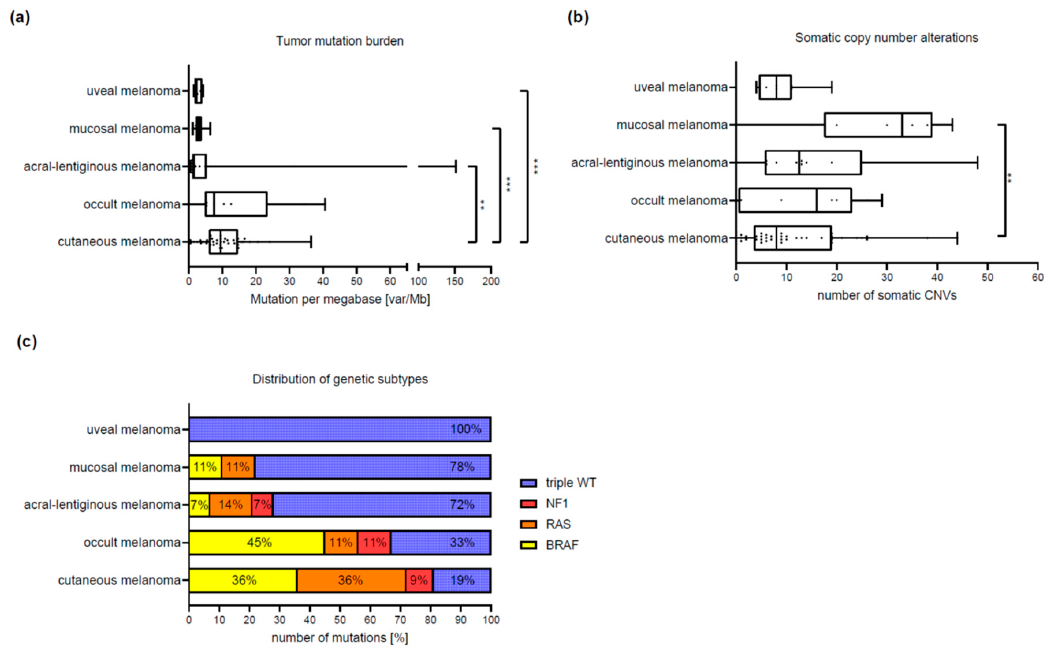
Figure 2. Tumor mutation burden, copy number variants and genetic